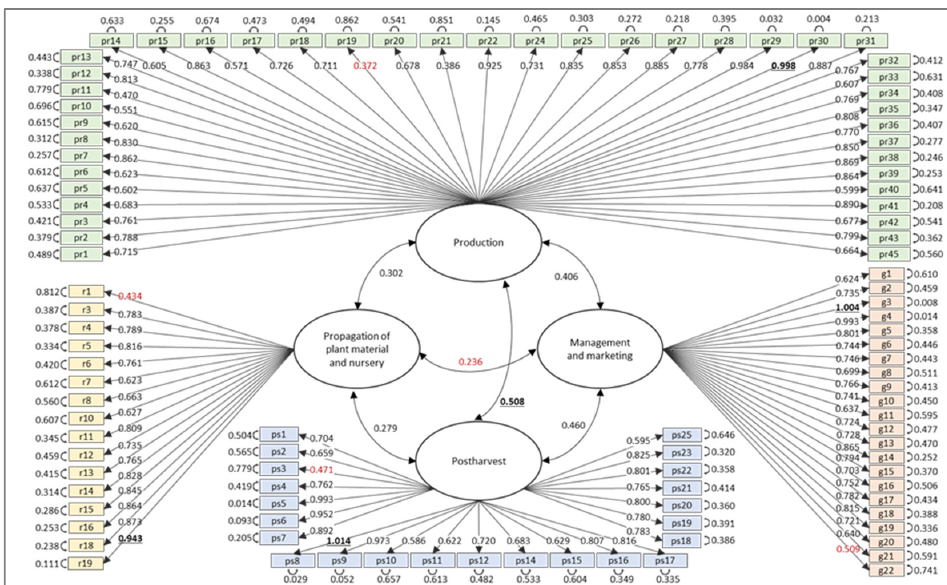
Figure 2. Confirmatory Factor Analysis of technological supplies consulted with experts, according to the stage of the value. The circular arrows indicate variances (latent variables) and covariance (center, between factors). The values in the straight arrows indicate the factor loading of each latent variable by group of technological supplies. For each group, the highest value is underlined and the largest value is highlighted in red. The coding of the latent variable is found in Appendix B.